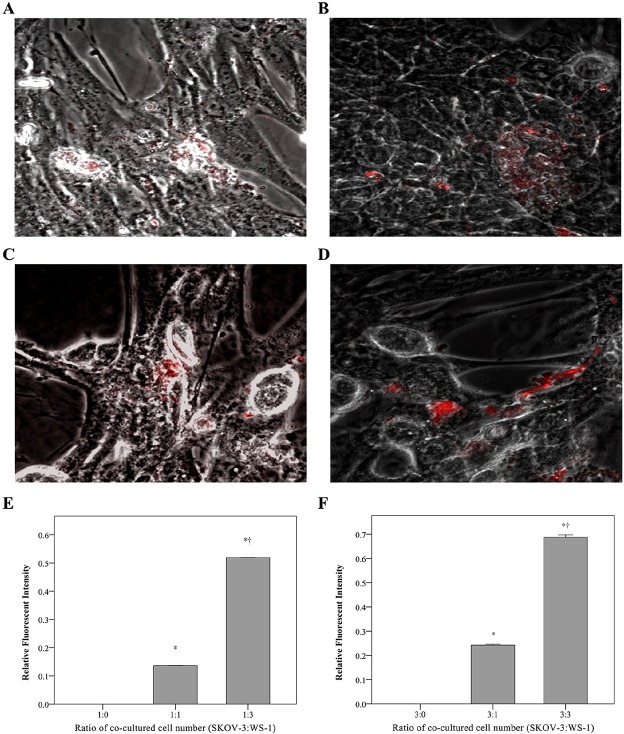
Detection of MMP-3 probes in SKOV3 and WS1 cell cocultures.(A–D) Detection of MMP-3 activity through NIRF imaging. (E, F) Quantification of the signal intensity. Either 1:1 or 3:1 (SKOV3:WS1) showed mild signal intensity (A,B), whereas 3:1 or 3:3 (SKOV3:WS1) exhibited remarkable signal intensity (C,D). The NIRF SI appeared undetectable in the culture of 2 × 104, or 6 × 104 SKOV3 cells alone. The mean MMP-3 concentration was significantly higher in cocultures with increasing WS1 cells than in SKOV3 cells cultured alone (p<0.001). The signal was significantly higher in the 1:3 (SKOV3:WS1) group than in the 1:1 group (0.52 vs. 0.14, respectively, p<0.001) (E). The mean MMP-3 concentration was significantly higher in the 3:1 and 3:3 (SKOV3:WS1) groups than in 3:0 group (0.24, 0.69 vs. 0, respectively; both p<0.001), and was significantly higher in the the 3:3 (SKOV3:WS1) cocultures than in the 3:1 cocultures (0.69 vs. 0.24, respectively; p<0.001) (F). MMP, matrix metalloproteinase; NIRF, near-infrared fluorescence; SI, signal intensity.